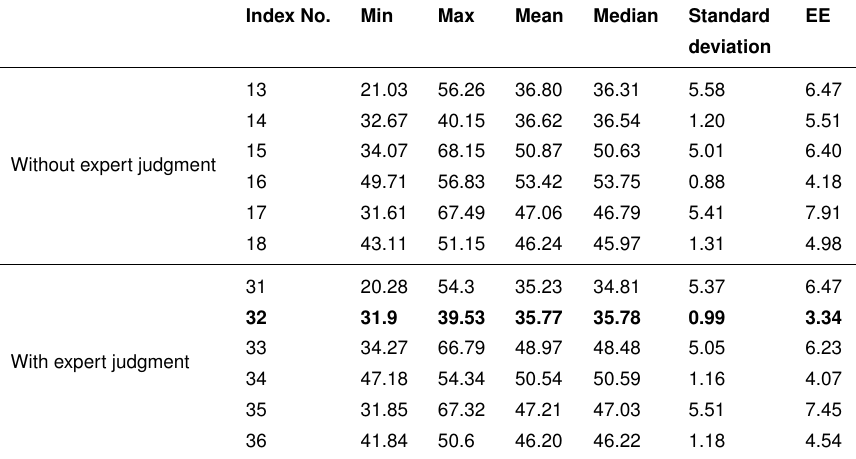
Table 4. Descriptive statistics and estimation errors for the HSI constructed using 1000 simulated binary data. Index No. Min Max Mean Median Standard EE deviation